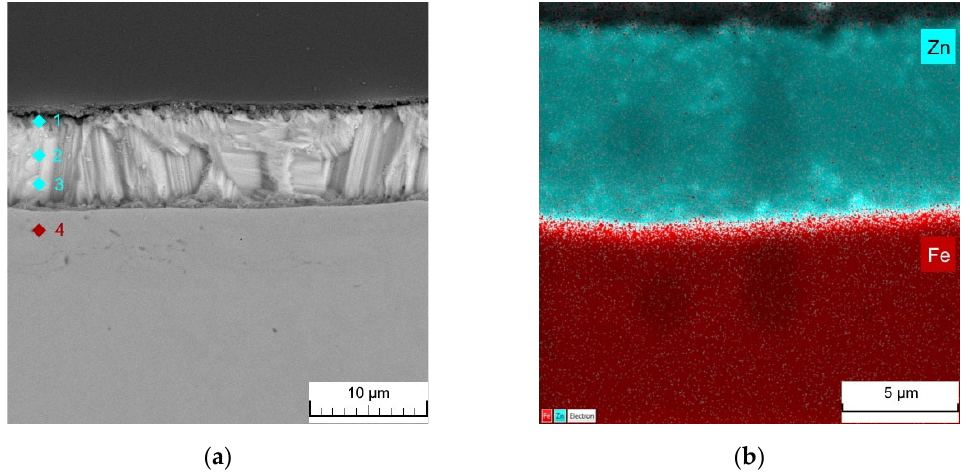
Figure 1. The microstructure of the Zn jet vapor ‐ deposited coating etched in 10 wt. % of NaOH ( a ) and SEM ‐ EDS element distribution map ( b ). Table 4. Results from the SEM ‐ EDS chemical point analysis, presented as atomic percentages.